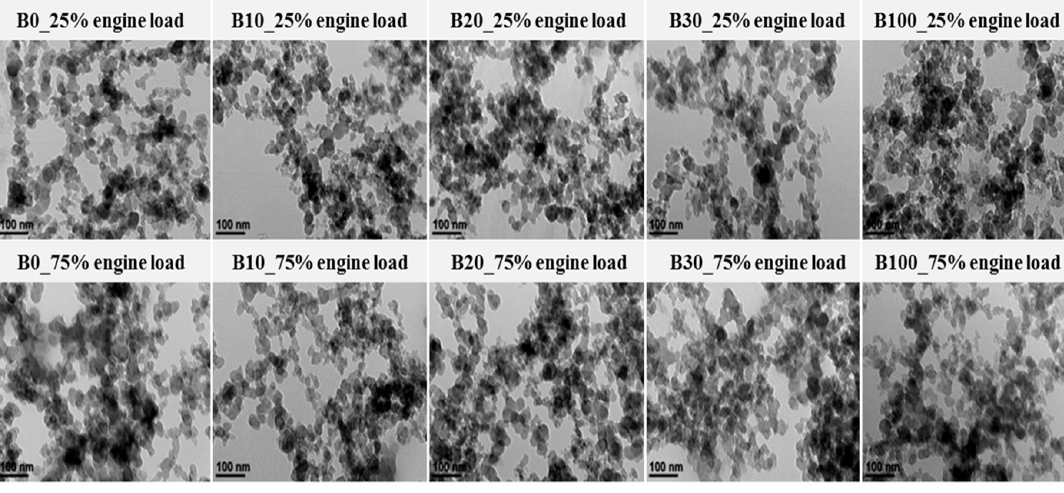
Figure 8. Comparisons of TEM images of the particulate matter (PM) primary particles at 25% and 75% engine loads.